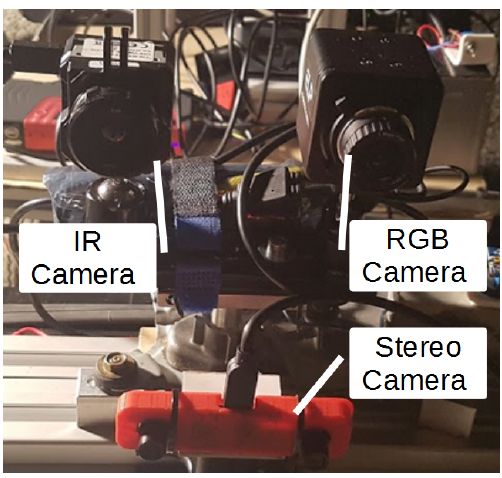
Figure 3. Vision sensors on rotation module.